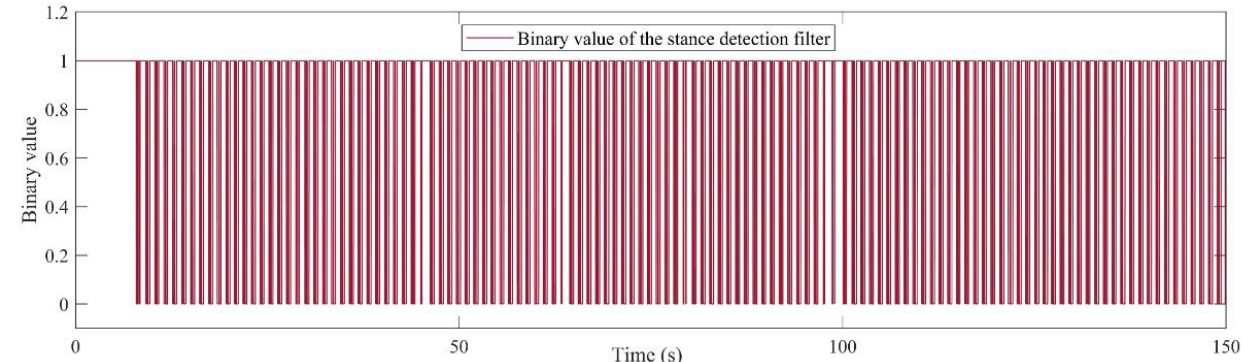
Figure 4. Output of the stance and still detection phase for 150 s walking. In order to detect one stance, all the three of the above conditions, given by Table 1, must be satisfied spontaneously. The recorded data is filtered using the median filter with a window size of at least 11 samples to prevent a faulty stance detection phase. The defined thresholds can be selected in special intervals. The intervals of thresholds for magnitude of acceleration and gyroscope, as well as acceleration variance, are defined in Table 1. The above thresholds can significantly affect the stance detection performance in different pedestrian situations, such as fast walking, slow walking, and running. Further, the amount of the sampling windows can be selected due to the processing speed and desired system accuracy. Figure 4 demonstrates the simple walking experiment at usual speed, which shows the detected stances during 150 s of a pedestrian’s walk. The figure shows the results of steps while all the three discussed conditions are satisfied. Table 1. Triple conditions of the stance detection